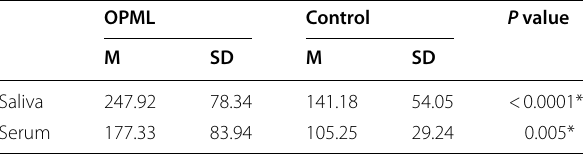
Table 3 Mean and standard deviation of saliva and serum regarding control and OPML groups and comparison between